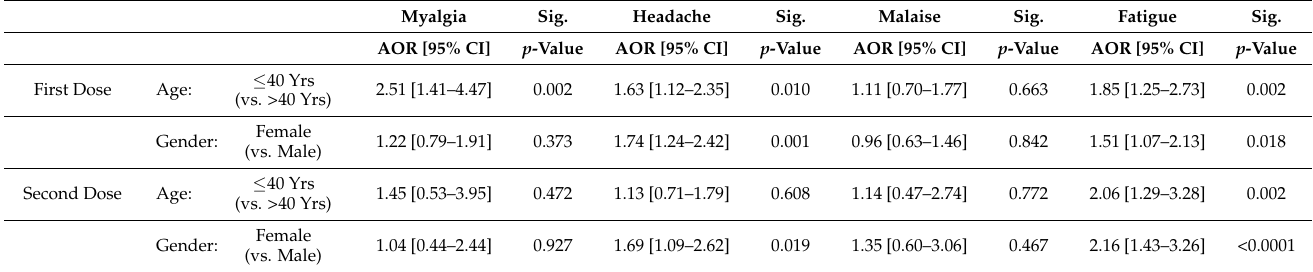
Table 5. Multiple logistic regression: effect of age and gender on myalgia, headache, malaise, and fatigue side effects.